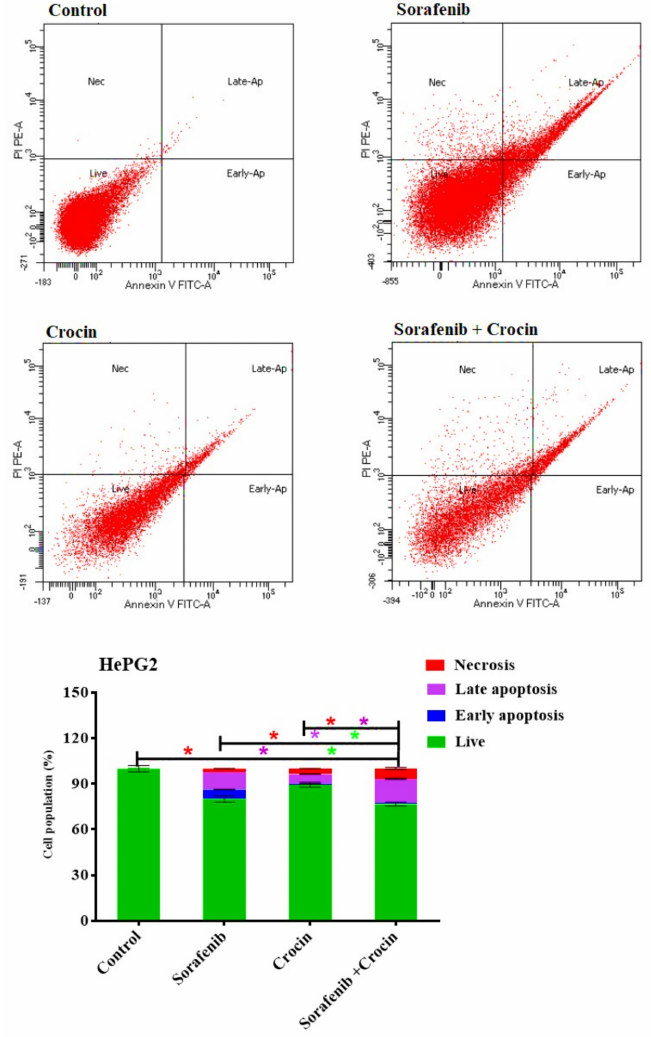
Figure 6. DNA cytometry analysis of Annexin V-FITC showing representative flow cytometry panels of apoptosis, necrosis, and cell vitality of HePG2 in response to 48 h exposure to media only (control) or (sorafenib, crocin, and (sorafenib/crocin), respectively). Cells population (%), including early apoptosis, late apoptosis, necrosis, and total cell death for the different treatments were shown in the lower panel. All data were presented as mean ± SEM for three replicates ( n = 3). Differences were considered significant at * p <